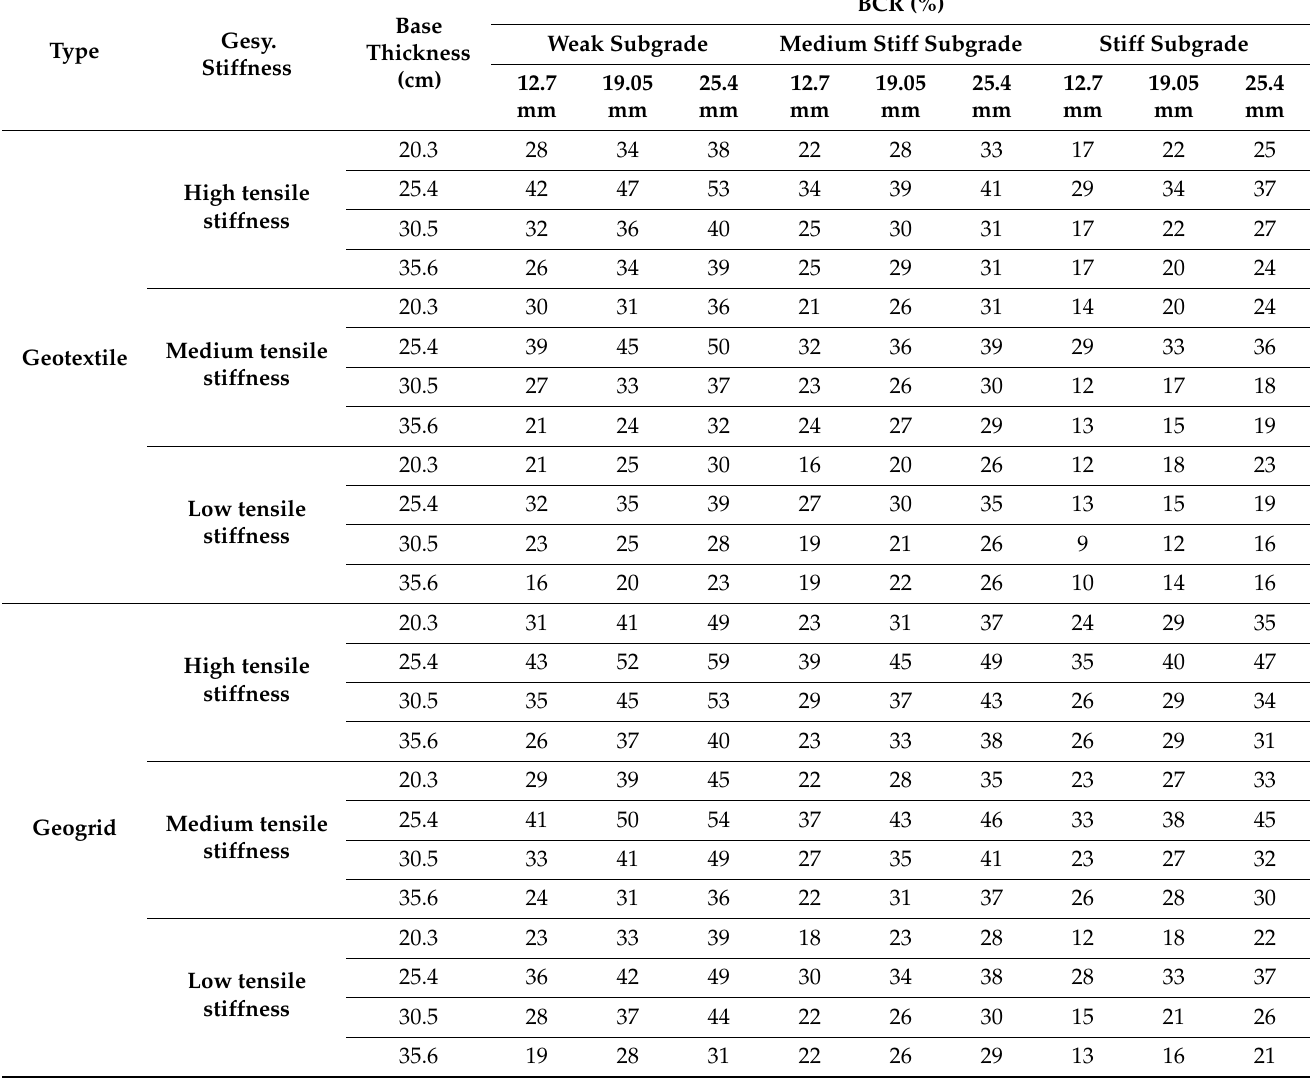
Table 8. Derived BCR values for reinforced cases over weak subgrade